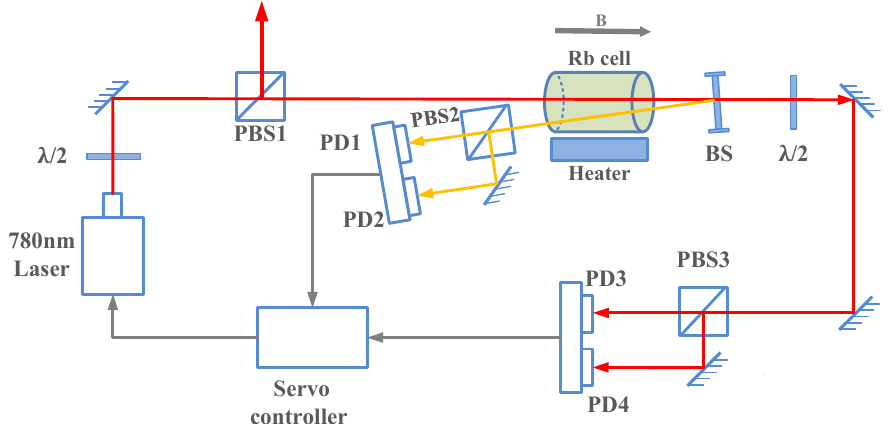
Figure 5. Experimental setup. PBS: polarizing beam splitter; λ /2: half wave plate; PD: photo detector; BS: plate beam splitter. (Figure reproduced from [22].)